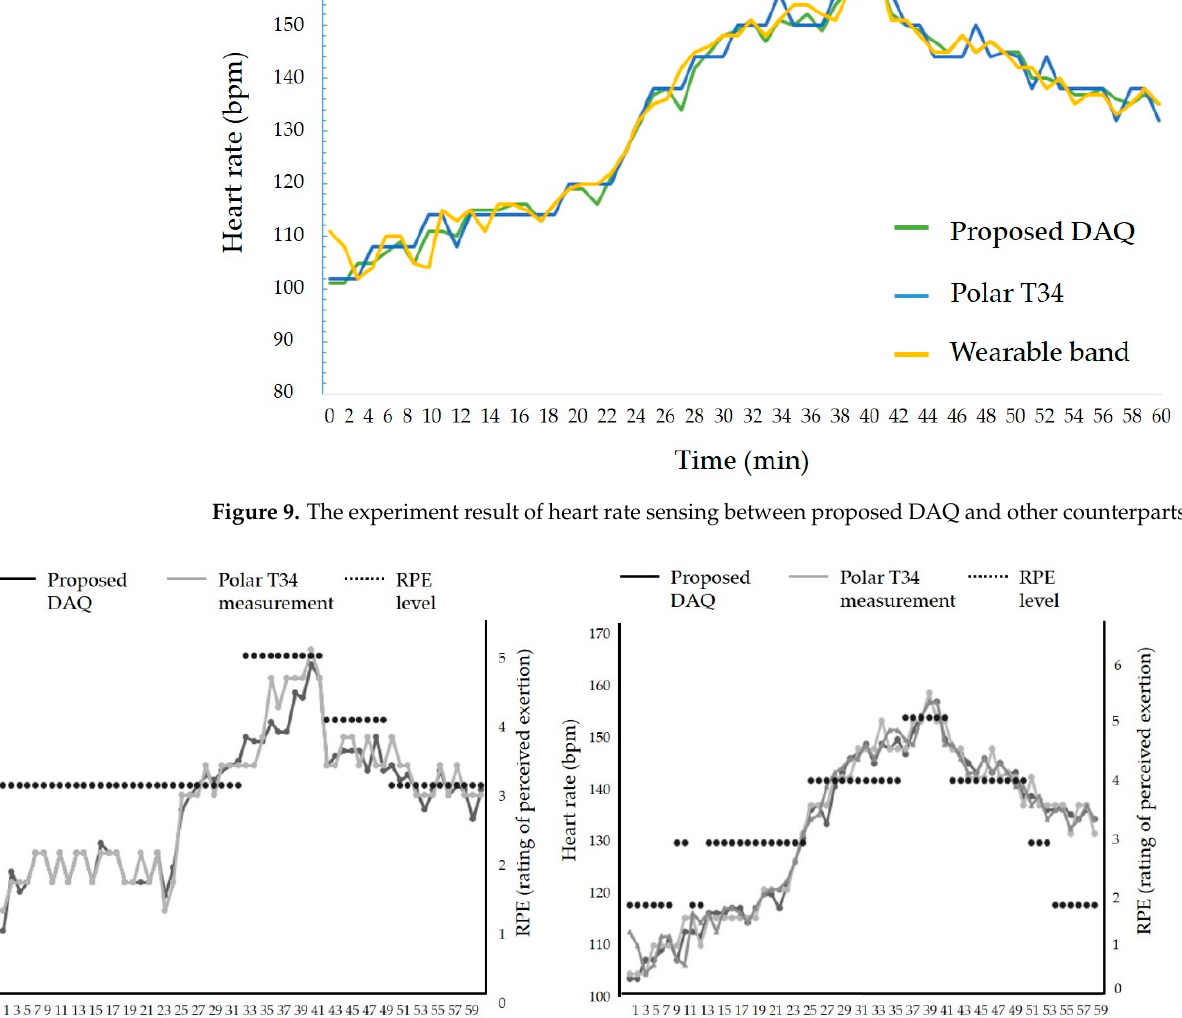
Figure 9. The experiment result of heart rate sensing between proposed DAQ and other counter- parts.